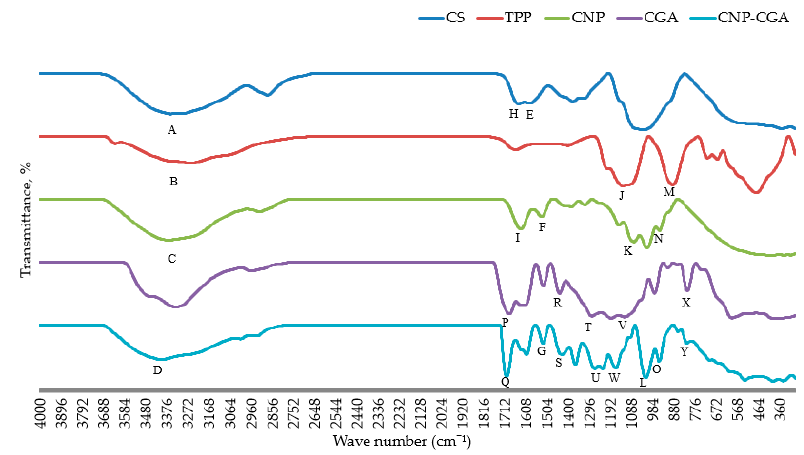
Figure 9. FTIR spectra of CS, TPP, CNP°, CGA, and CNP°-GCA. The successful formation of CNP° and CNP°-CGA were discerned through the presence of functional group peaks. Freeze dried samples were used to ensure sensitivity of analysis, also to remove non-specific background peaks. Alphabet labeling denotes important functional groups of samples, and is further elaborated in Table 3. Table 3. Summary of functional groups present in FTIR spectra of CS, TPP, CNP°, CGA, and CNP°- GCA. Functional